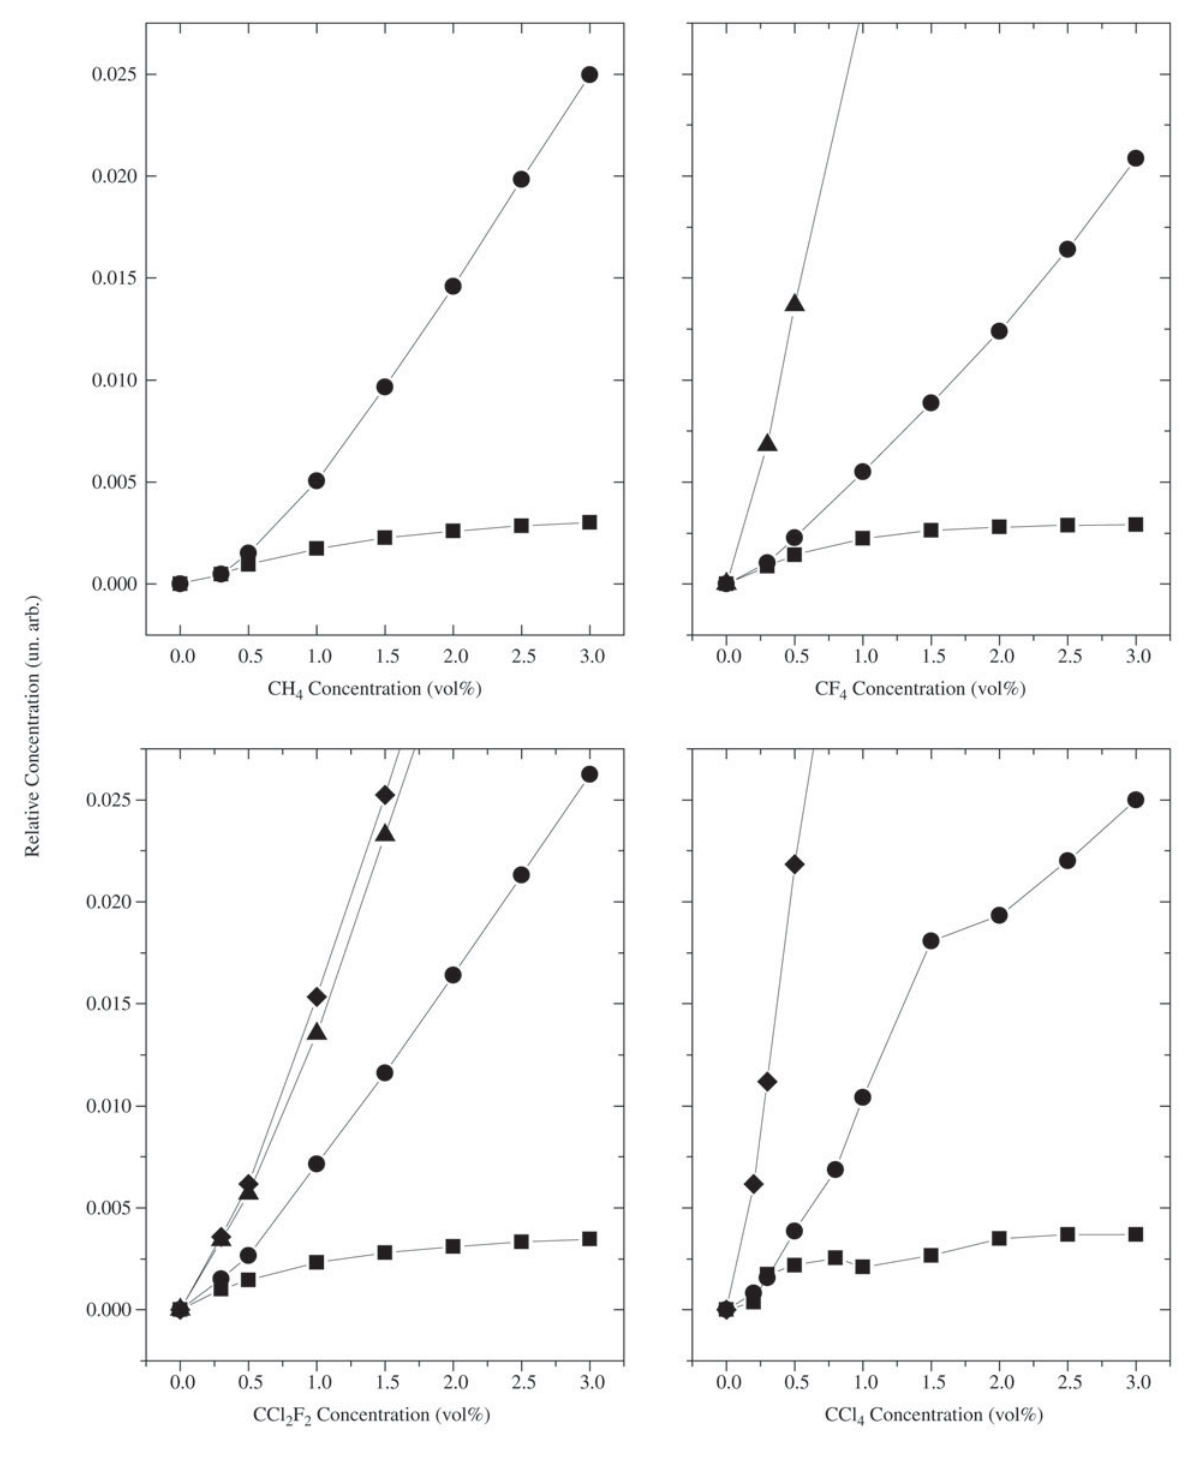
Figure 2. Relative concentration of the stable species in the exhaust gas as a function of concentration in the inlet gas of, respectively, CH CF , CCl F and CCl , in mixture with hydrogen. (cid:132) CH 4 2 2 4